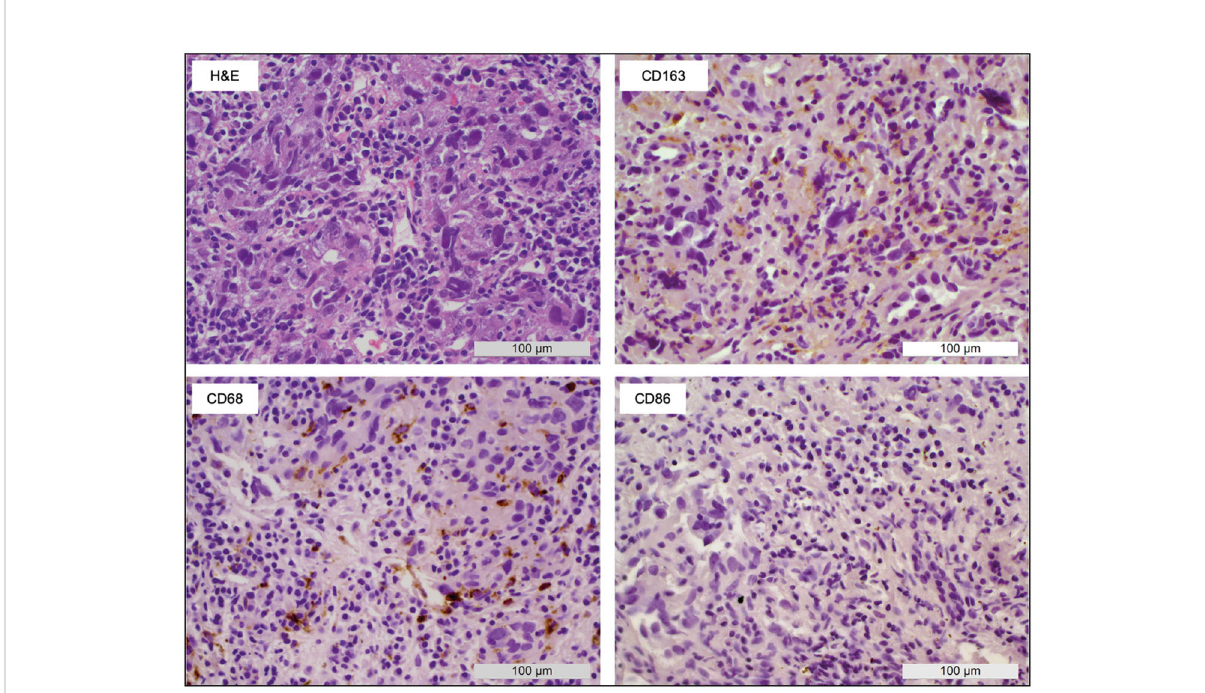
FIGURE 2 Macrophage polarization within HCC biopsies. A representative sample shows the appearance of macrophages in tumor tissue obtained before local ablation. H&E staining as well as CD68 (pan macrophage), CD86 (M1), and CD163 (M2) IHC allowed the identi fi cation of large areas with M2-type macrophages (CD163+) whereas M1-type macrophages (CD86+) were almost completely